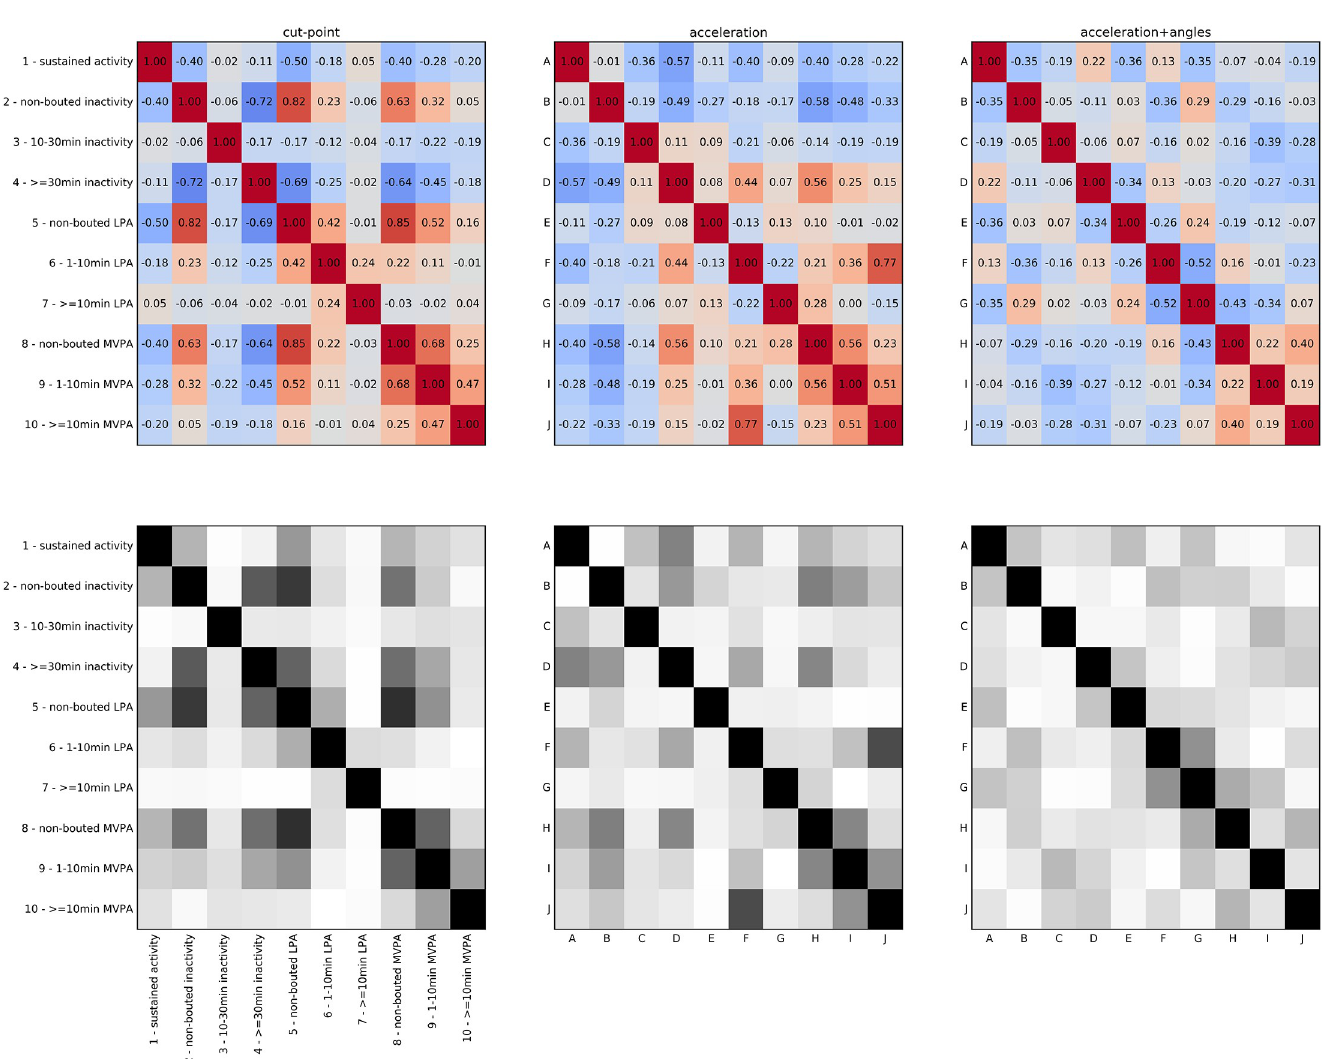
Fig 3. Correlation (top) and absolute value of correlation (bottom) matrices for cut-points categories and model states. The values in the bottom plots are not shown, but can be derived from the top plots by the reader.